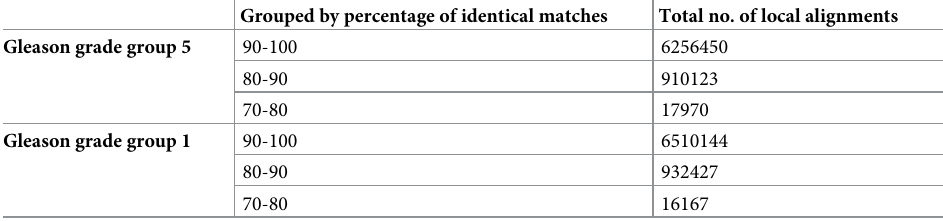
Table 2. Sequence similarity within a Gleason grade group of 5 and 1 for BRCA 2 blood DNA sequences.